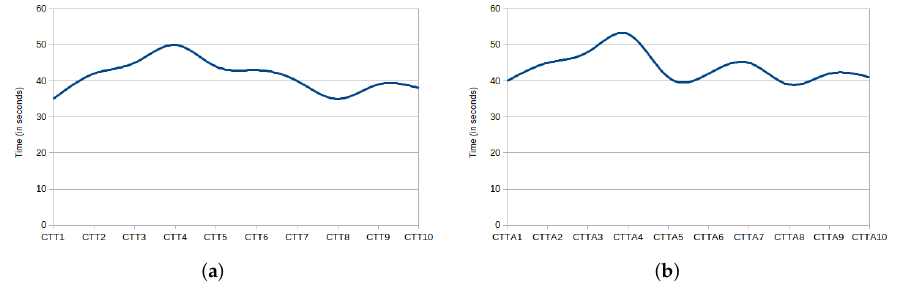
Figure 13. Performance evaluation on contract term creation and audit. ( a ) Time spent on contract term creation. ( b ) Time spent on contract term audit.